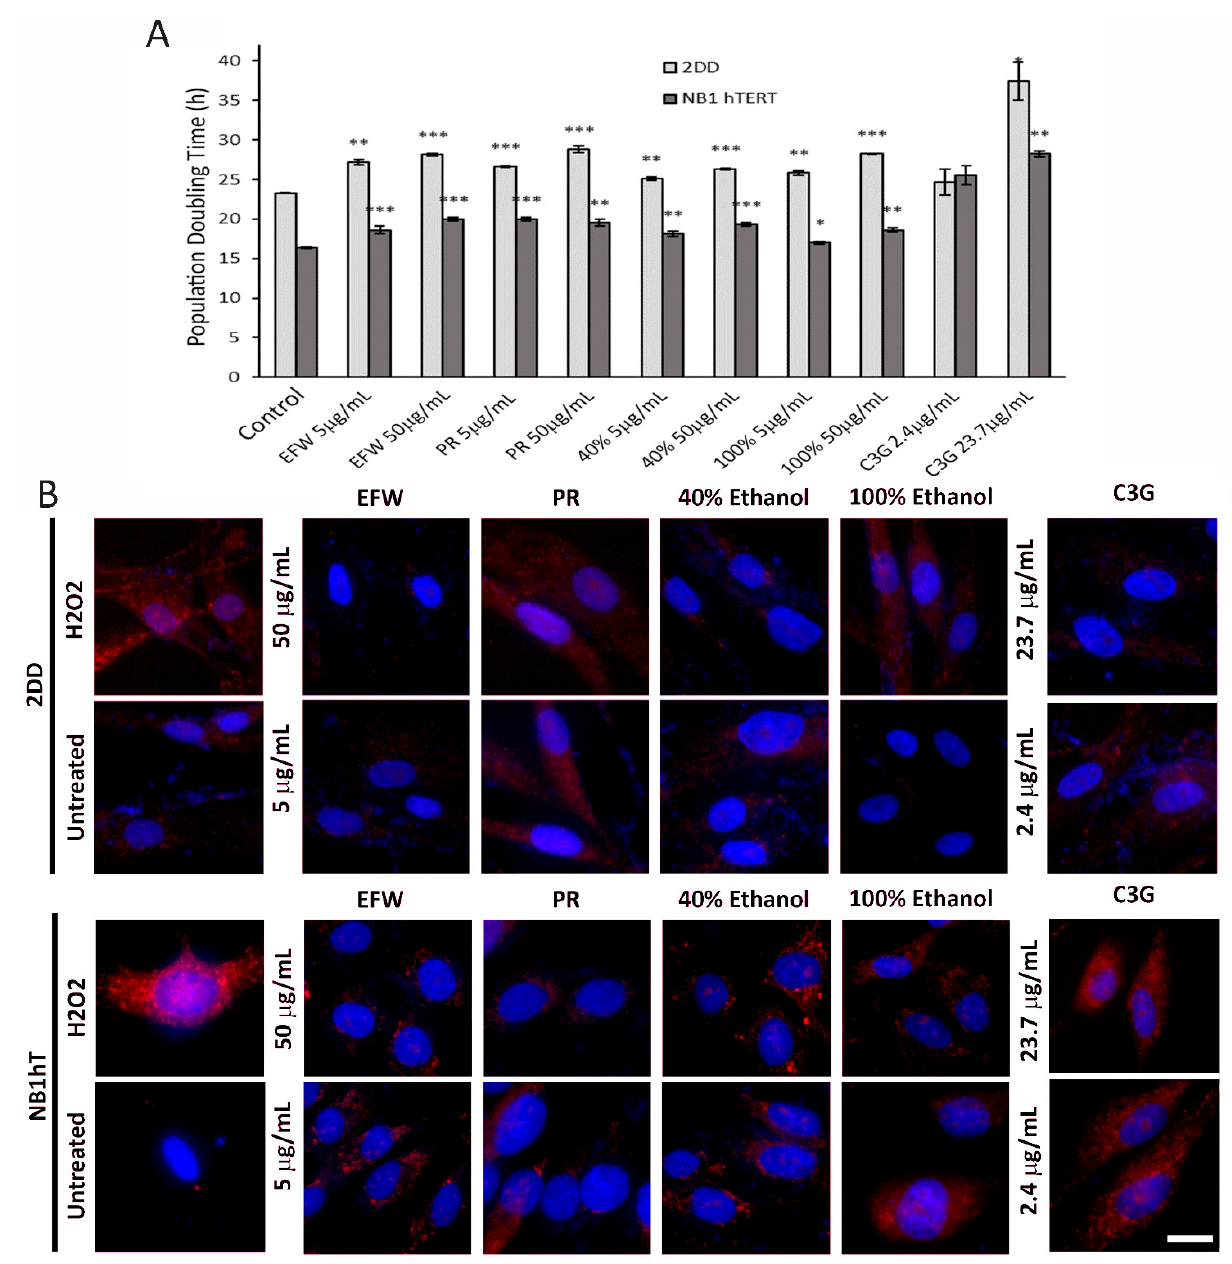
Figure 1. Haskap Phenolics Impact Fibroblast Growth and Reduce Free Radicals Intracellularly. ( A ) Population doubling times for 2DD (light grey bars) and NB1 hTERT (dark grey bars) fibroblasts after 72 h treatment with Tundra variety haskap phenolic extracts (5 µ g/mL or 50 µ g/mL) and C3G (2.4 µ g/mL or 23.7 µ g/mL). Treatment abbreviations: EFW, ethanol:formic acid:water extract; PR, phenolic rich extract; 40%, 40% ethanol fraction; 100%, 100% ethanol fraction; C3G, cyanidin-3- O -glucoside. p -values = * p < 0.10, ** p < 0.05, *** p < 0.01. ( B ) 2DD and NB1hT cells grown on coverslips were treated with 5 µ g/mL or 50 µ g/mL of EFW—ethanol:formic acid:water, PR—phenolic rich, 40%—40% ethanol fraction, 100%—100% ethanol fraction and C3G—cyanadin-3- O -glucoside (2.4 µ g/mL or 23.7 µ g/mL) for 72 h. Following this, cells were washed, exposed to 200 µ M H 2 O 2 for 30 min, fixed and stained with Mitotracker Orange (red) and DAPI (counterstain for DNA—blue). Images for each were collected using equivalent exposure times. Scale bar = 10 μ m.